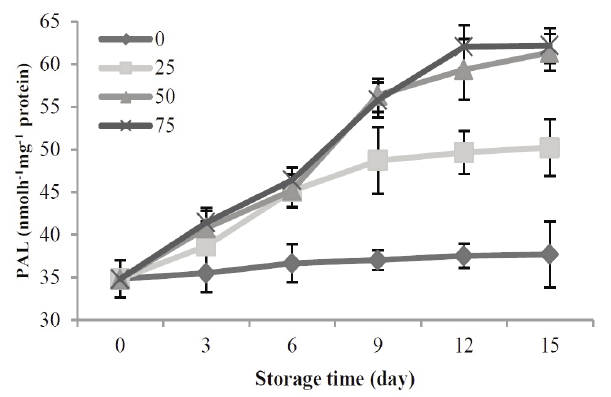
Fig. 4 ­ Phenylalanine ammonia­lyase (PAL) activity in figs ( Ficus carica L.) ‘Siyah’ fruit treated with Aloe vera gel (0, 25, 50 and 75%) during cold storage at 2°C. Vertical bars repre­ sent standard error of means of three experiments with four replicates determinations per experiment.